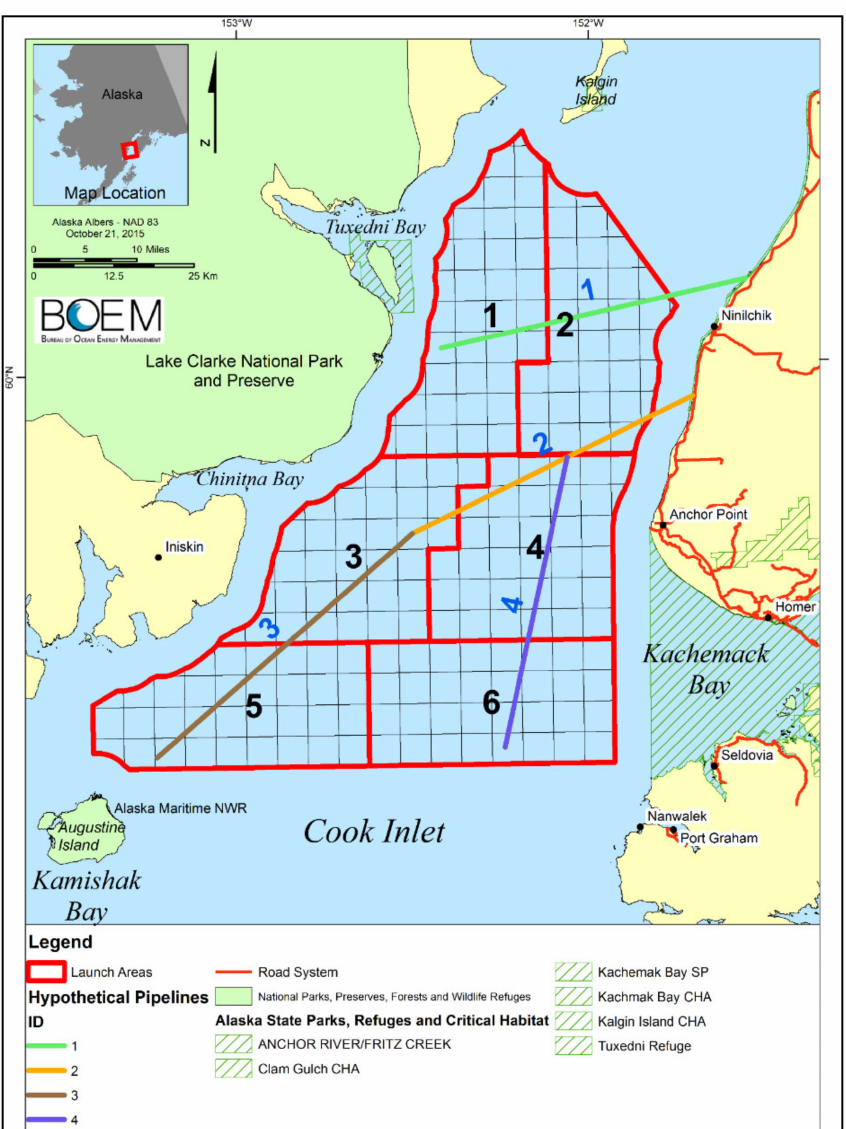
Figure 6. Proposed Lease Sale 244 area with hypothetical launch areas and pipelines. Launch areas and pipelines are used in the oil spill trajectory analysis